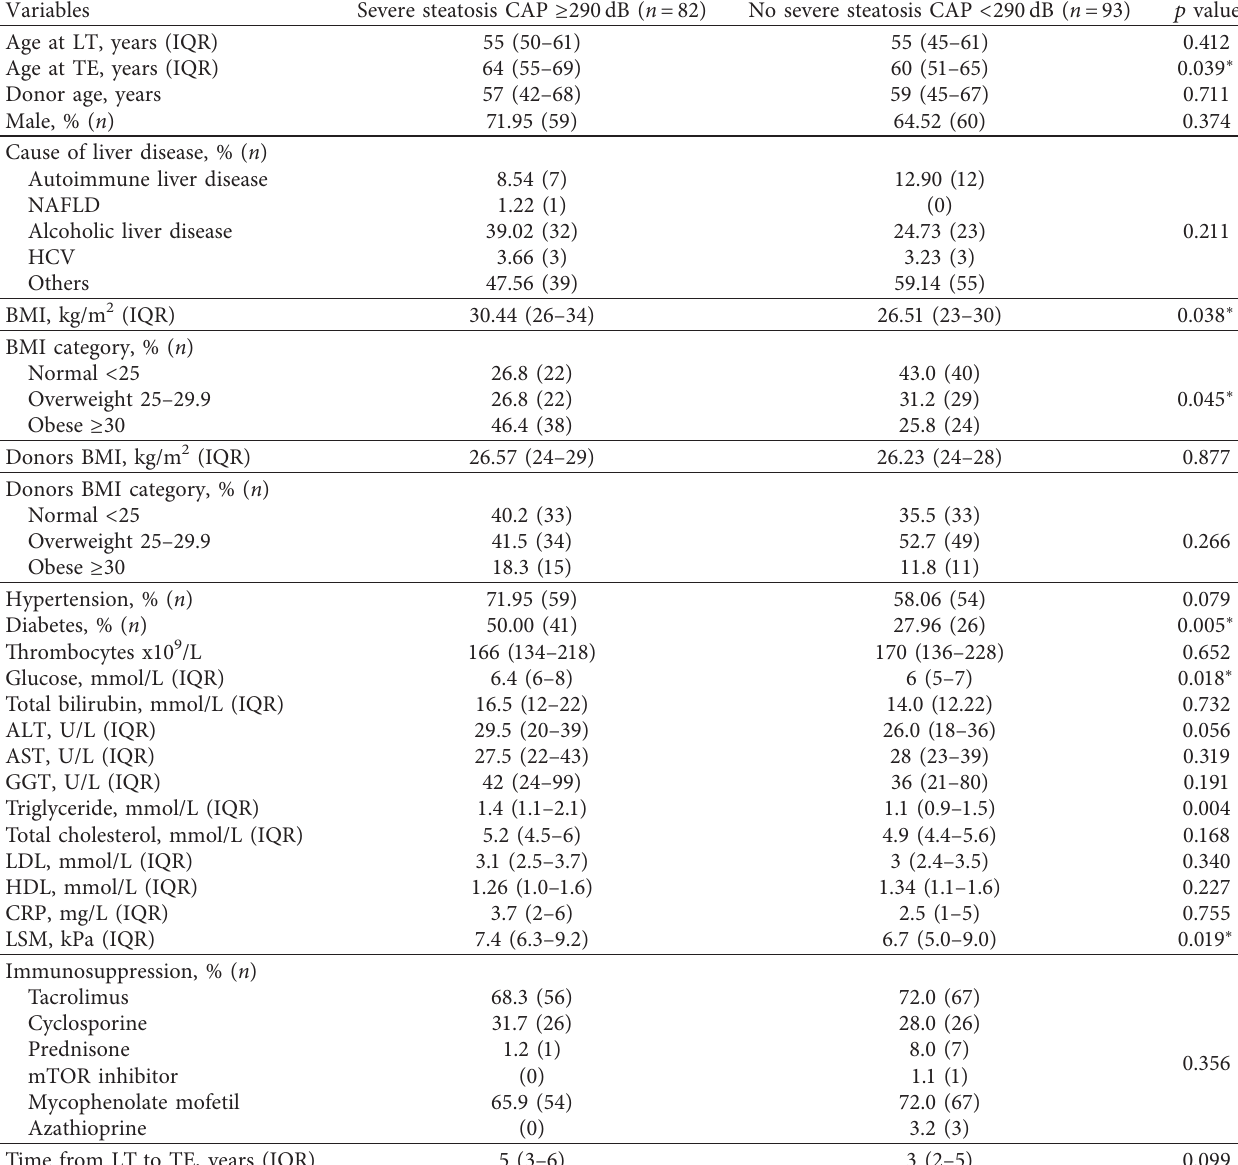
Table 2: Comparison of groups with and without severe steatosis (elevated CAP ≥